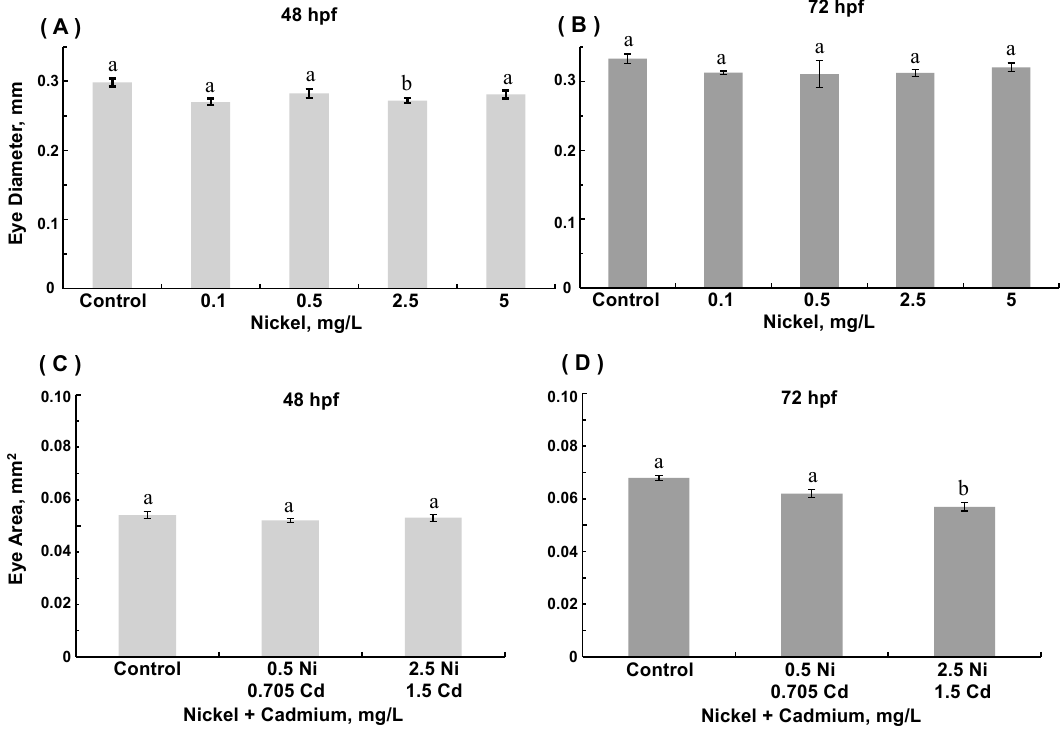
Figure 3. Eye diameter in 48 hpf ( A ) and 72 hpf ( B ) zebrafish embryos reared in medium containing 0.1–5 mg / L Ni, and eye area in 48 hpf ( C ) and 72 hpf ( D ) embryos reared in medium containing combinations of 0.5 mg / L Ni + 0.15 mg / L Cd or 2.5 mg / L Ni + 0.705 mg / L Cd. ( A ): Eye diameter at 48 hpf with Ni exposure, ANOVA p = 0.0019. ( D ): Eye area at 72 hpf with combined metal exposure, ANOVA p < 0.0001. (Data are means ± SEM for N = 50–80 surviving embryos.).